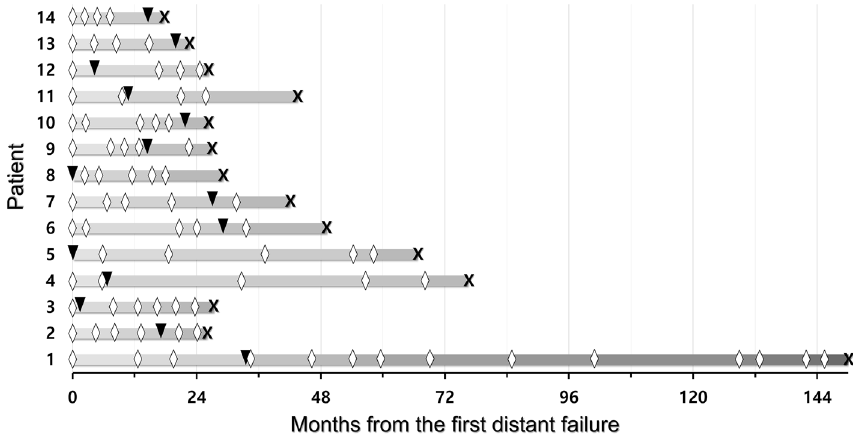
Figure 5. Timeline of the 14 patients who underwent salvage WBRT due to distant failure after the first GKRS. The diamond symbols indicate the repeat GKRS. The black arrow heads indicate the salvage WBRT. The cross “X” indicates the time of death. GKRS gamma knife radiosurgery, WBRT whole-brain radiotherapy.